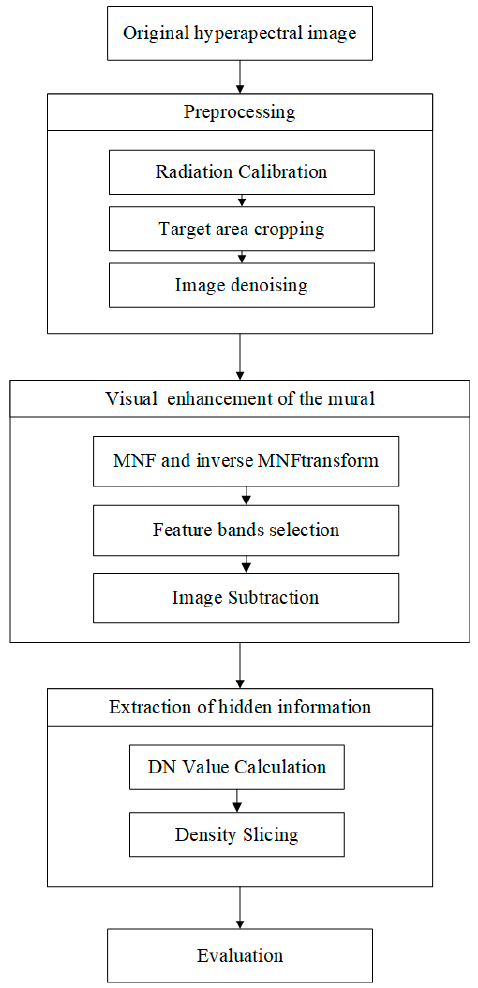
Figure 2. The overall workflow of the proposed method.